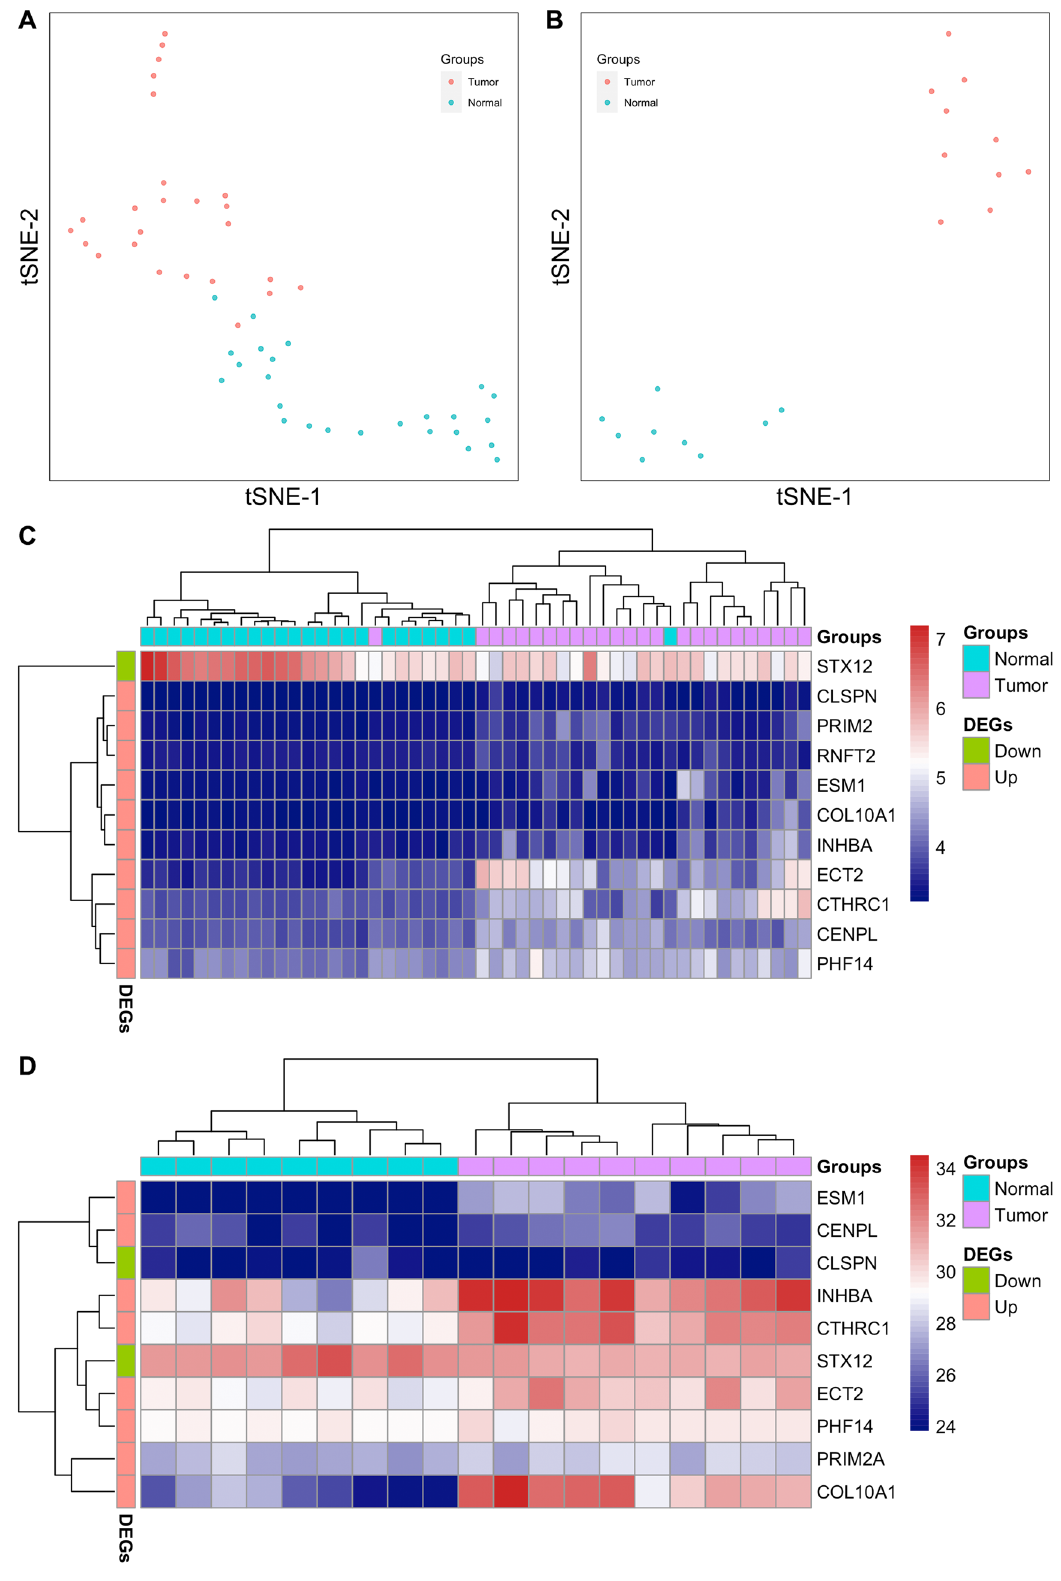
Figure 4. Classification between gastric tumor and normal tissues. ( A ) T-SNE plots displayed the distribution of tumor and normal samples based on the 11 candidate genes in the GSE33335 dataset. ( B ) T-SNE plots displayed the distribution of tumor and normal samples based on the ten candidate genes in the GSE103236 dataset. ( C ) Bi-clustering heatmap of the 11 candidate genes and 50 samples in the GSE33335 dataset. ( D ) Bi-clustering heatmap of the ten candidate genes and 19 samples in the GSE103236